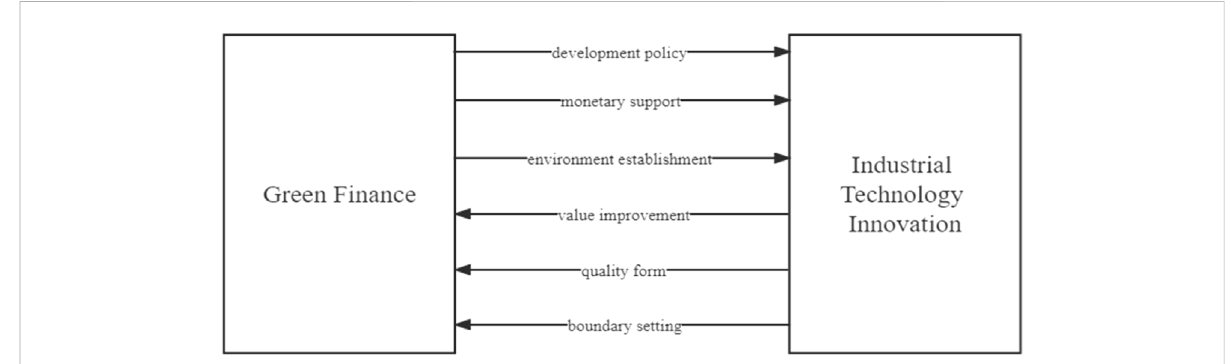
FIGURE 1 Coupling coordination mechanism of green fi nance and industrial technology innovation.